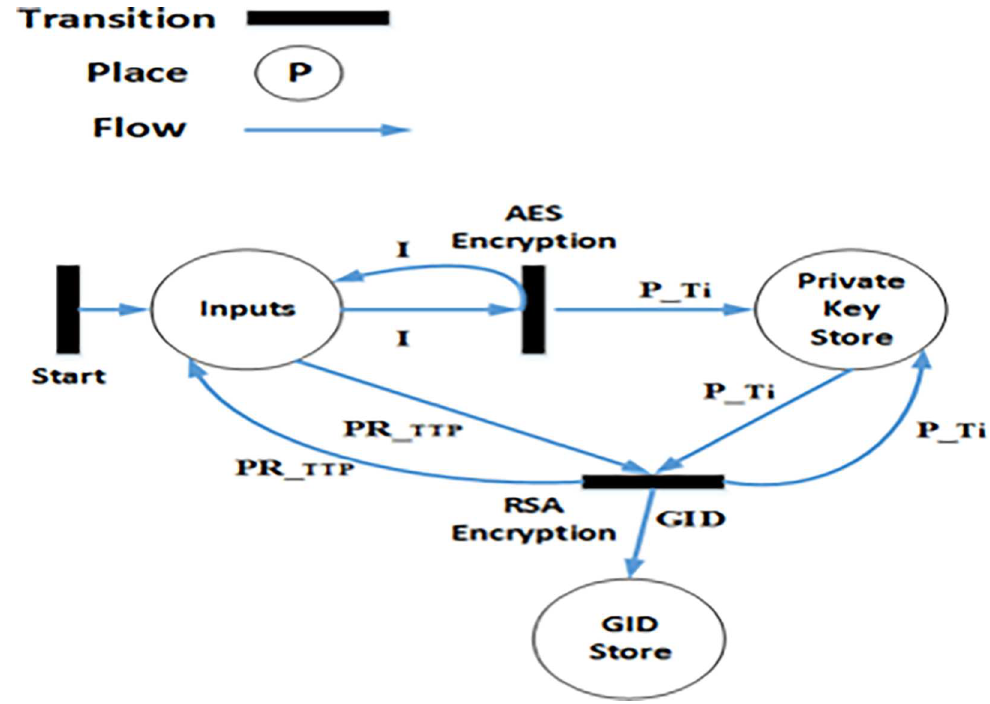
Fig 4. Algorithm 1: Generation of GID